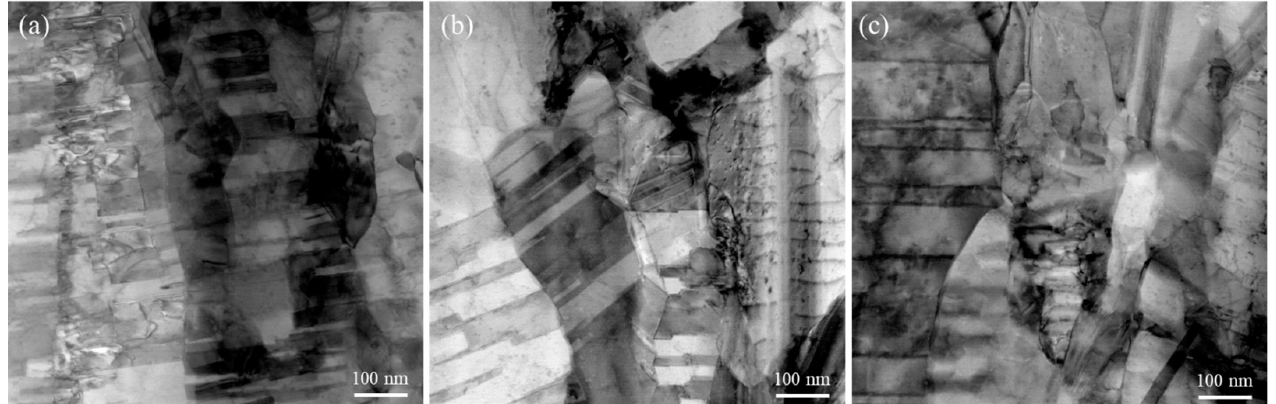
Figure 4. TEM micrographs of the 15- μ m thick nt-Cu foils electroplated with different concentrations of Cu 2+ : ( a ) 0.3 M; ( b ) 0.5 M; ( c ) 0.8 M.